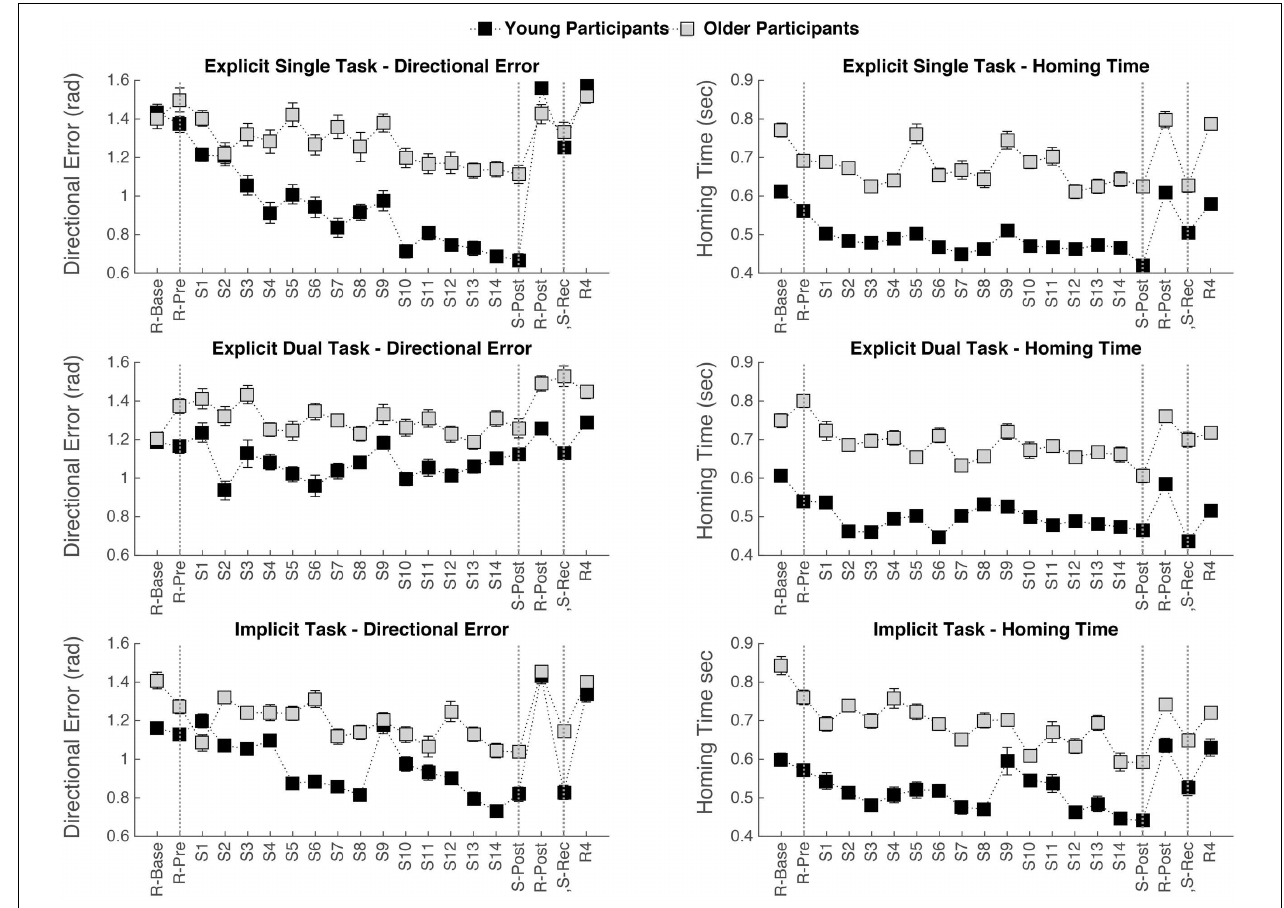
FIGURE 3 | Mean value and standard-error bar for each age group on each test block showing; the absence of an aging effect at the beginning of the experiment for directional error, a slower homing-time for the older participants, general practice effects on directional error and homing-time (R-Pre vs. S-Post), and the effects of sequence removal and re-introduction (the phase between the two vertical dotted lines on the right